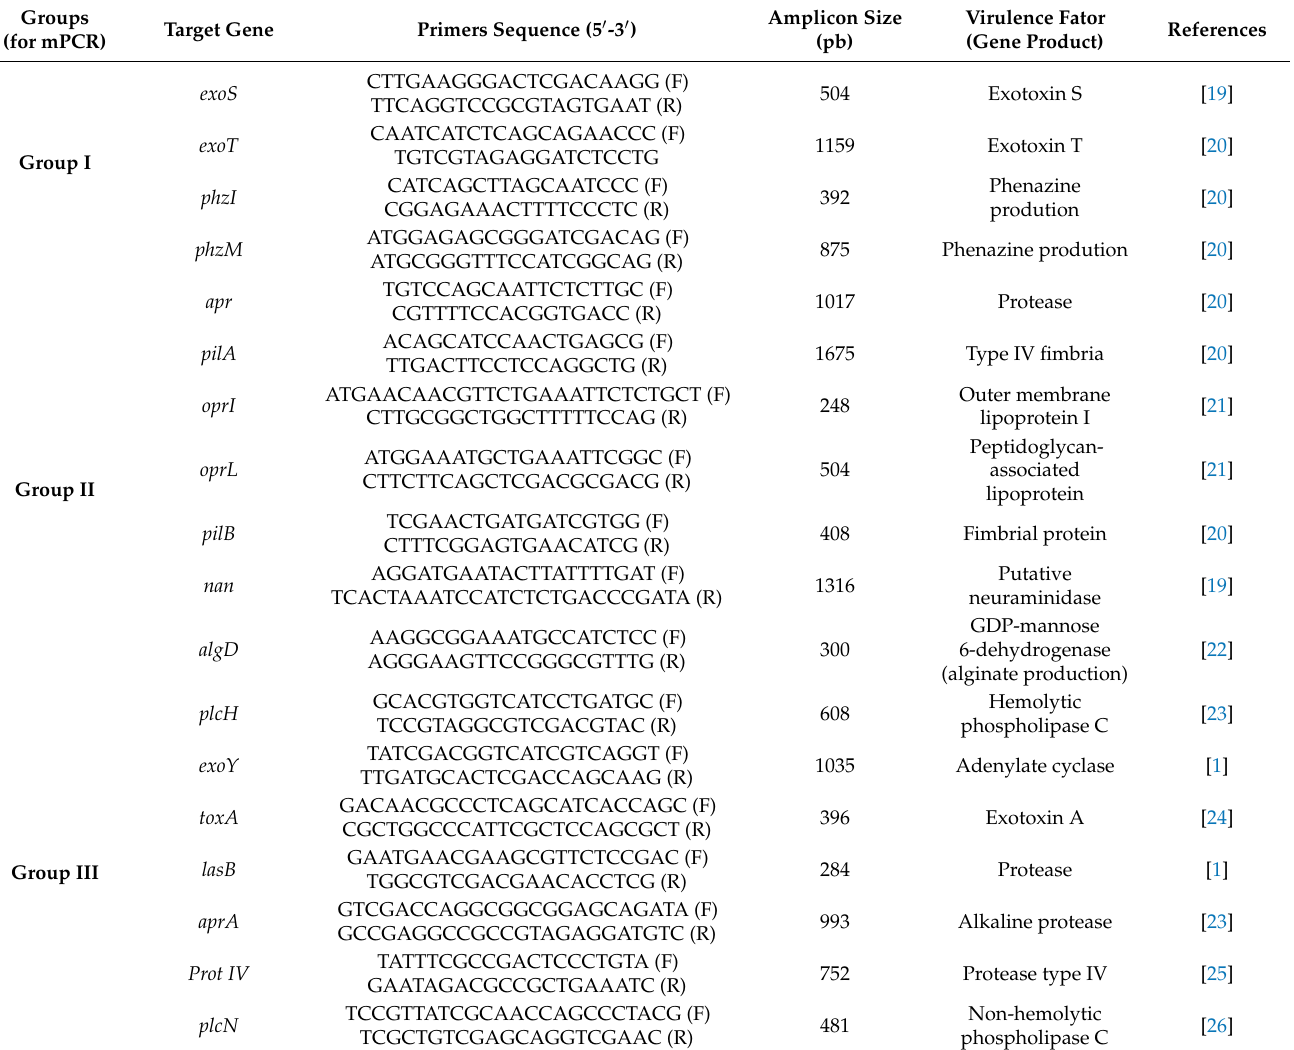
Table 1. Primers used for the detection of different virulence genes by mPCR in Pseudomonas aeruginosa isolates evaluated in this study.